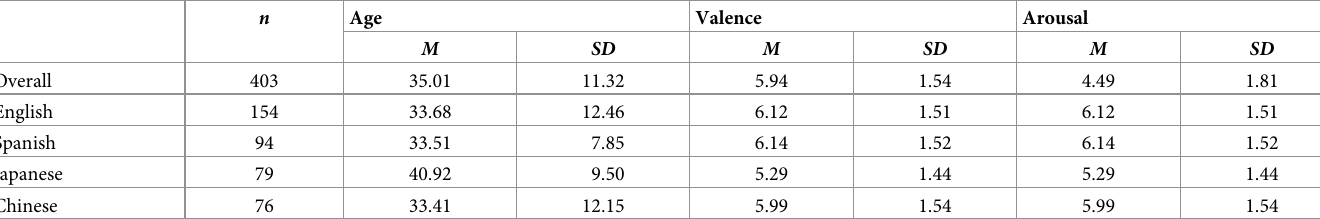
Table 1. Participant number, age, and starting emotional state of participants by language group in Experiment 1.